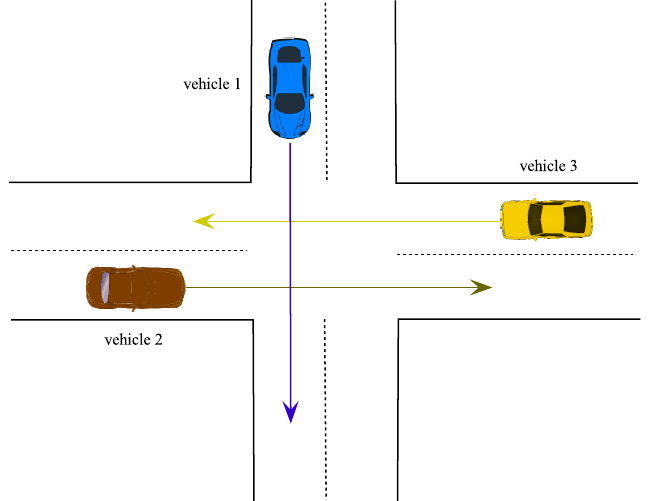
Figure 5. Illustration of the simplified intersection